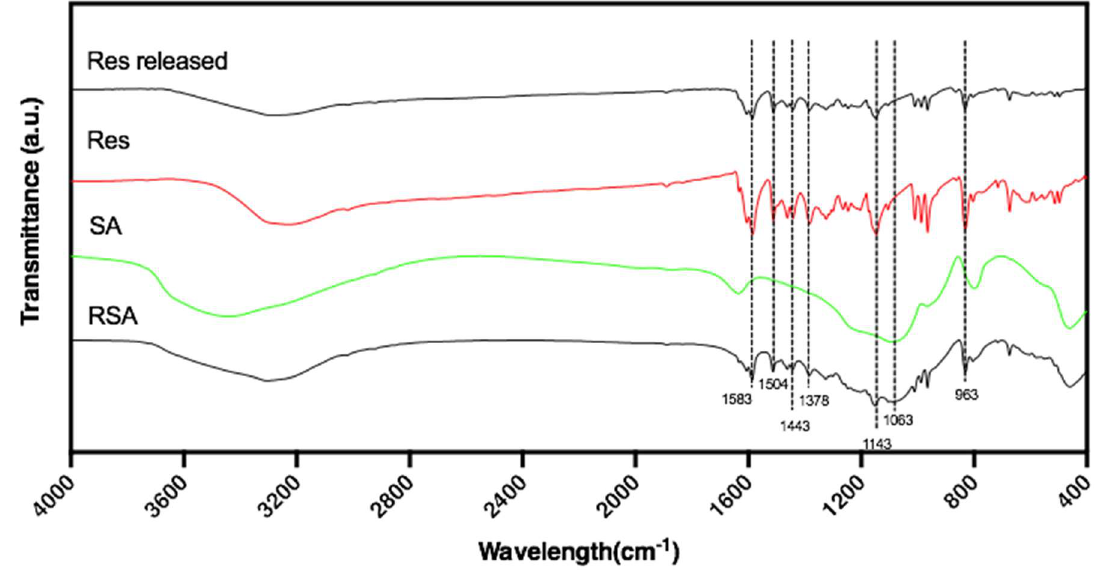
Figure 3. FTIR spectra of resveratrol-loaded silica aerogel (RSA), resveratrol (Res), silica aerogel (SA), and Res released from RSA in phosphate-buffered saline (PBS) (Res released).